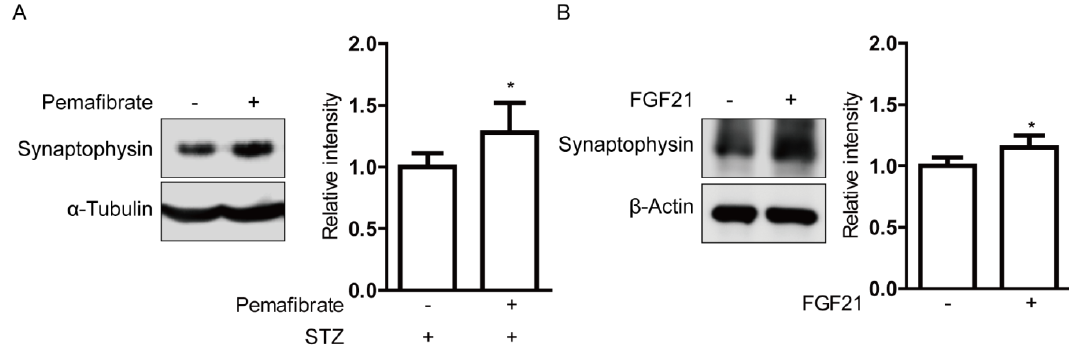
Figure 6. Increase in synaptophysin expressions by pemafibrate and fibroblast growth factor21 (FGF21) in STZ-induced diabetic retinas and di ff erentiated pheochromocytoma (PC)12D cells. ( A ) Representative immunoblots and quantitative analysis for synaptophysin and α -Tubulin showed that pemafibrate significantly increased expression of synaptophysin in STZ-induced diabetic retinas ( n = 4–7 per group). ( B ) Representative immunoblots and quantitative analysis for synaptophysin and β -Actin showed that long-acting FGF21 (100 ng / mL) significantly increased synaptophysin expression in di ff erentiated PC12D cells ( n = 5 per group). * p < 0.05. Bar graphs are presented as mean with ± standard deviation. The data were analyzed using Student’s t